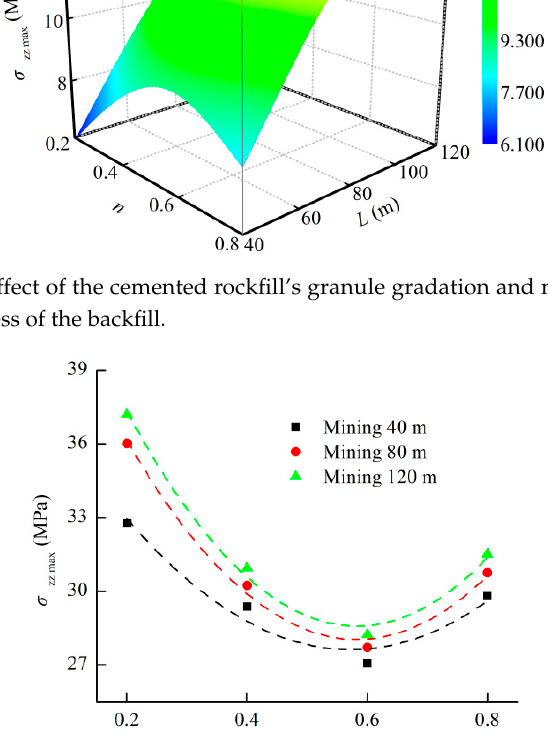
Figure 19. Relationship between the maximum stress of the rock mass in the coalface and the Talbot index of the cemented rockfill at different mining distances.